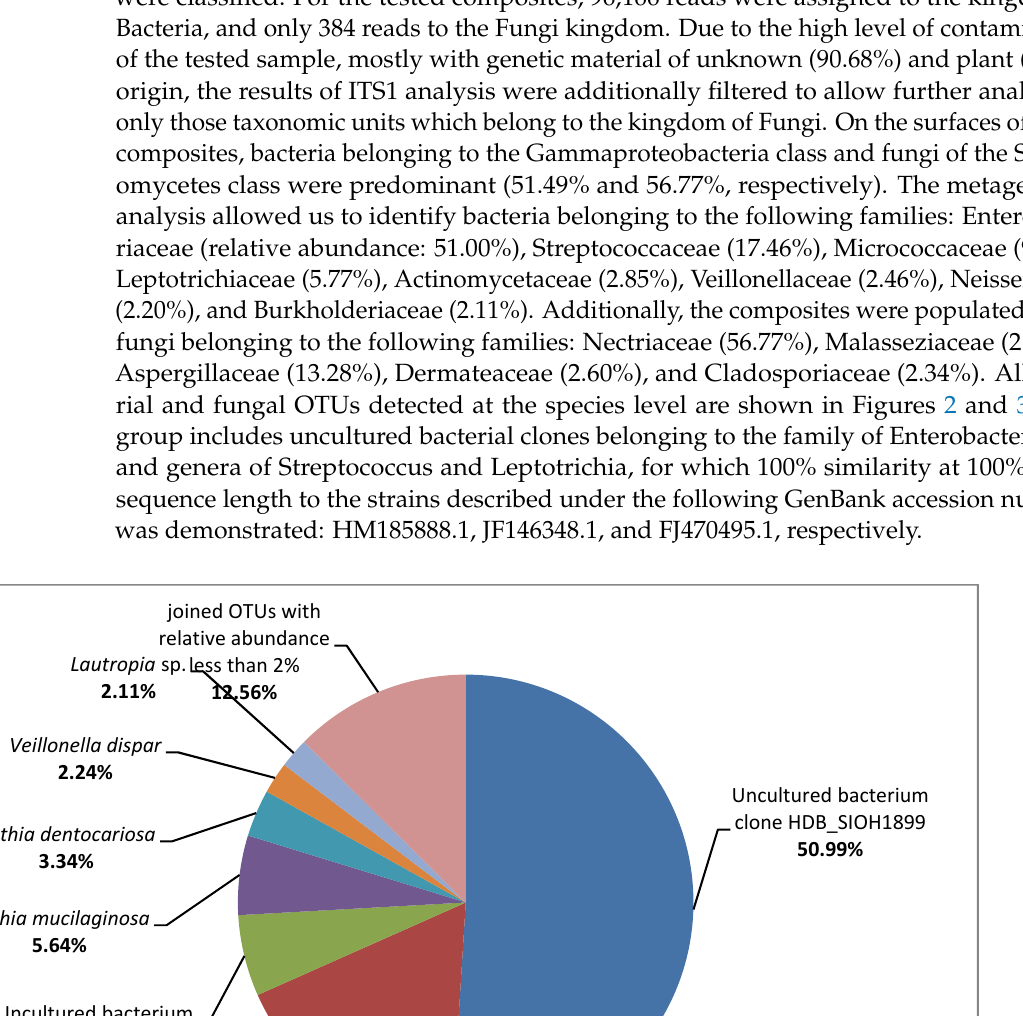
Figure 3. Identification results of the fungi isolated from the composite surfaces, using the NGS method. Taking into account OTUs with the relative abundance <2%, a much greater variety of bacterial taxa than the fungal ones was detected at all analyzed taxonomic levels (e.g., 33 bacterial OTUs vs. 9 fungal OTUs at the family level, and 61 bacterial OTUs vs. 12 fungal OTUs at the species level). The following exemplary OTUs with the relative abundance <2% were detected for the bacteria Actinomyces sp., Aggregatibacter segnis , Corynebacterium durum , Haemophilus parainfluenzae , Neisseria subflava , Prevotella spp. ( P. melaninogenica and P. nigrescens), Rothia aeria , and Streptococcus anginosus ; and for the fungi Alternaria alternata , Cladosporium delicatulum , Cladosporium halotolerans , Naganishia cerealis , and Saccharomyces cerevisiae. Additionally, many of the sequences with the rela- tive abundance <2% did not match to the cultivable microorganisms. For example, the bacteria belonging to the TM7 phylum (Saccharibacteria) were detected.